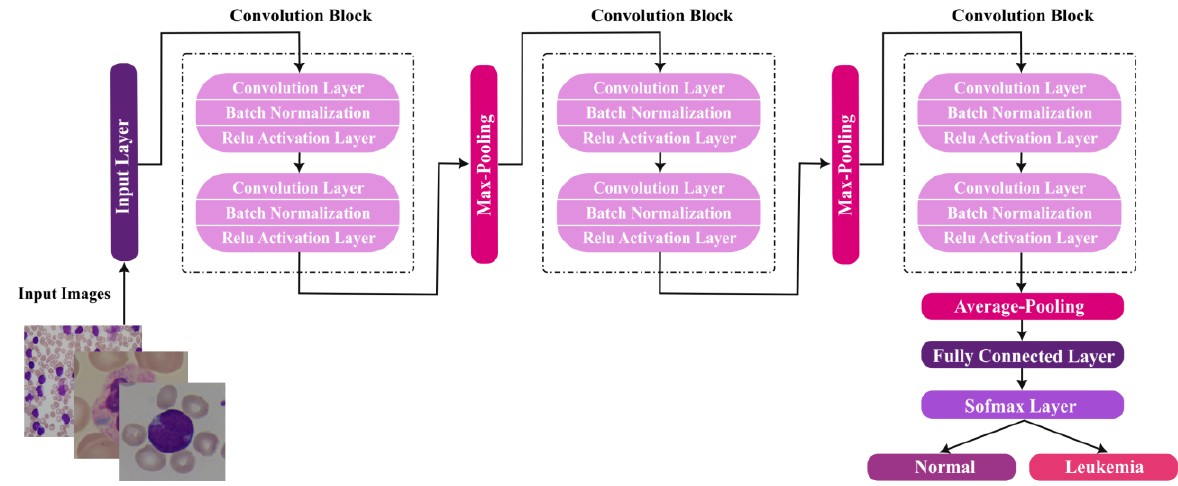
Figure 5. Architecture of the optimal Bayesian-based CNN model for ALL detection.